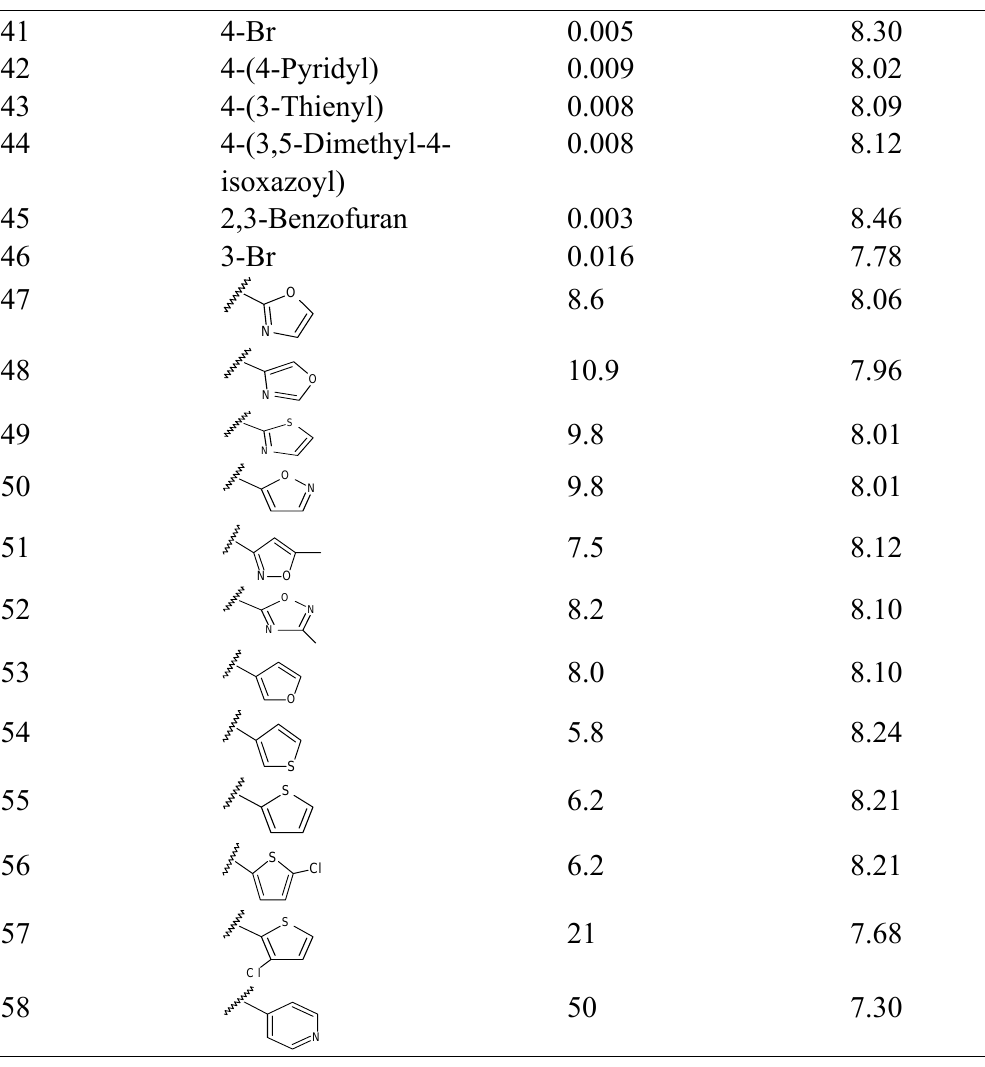
Table 3. Structures and biological activities of the N,N’ -diphenylureas